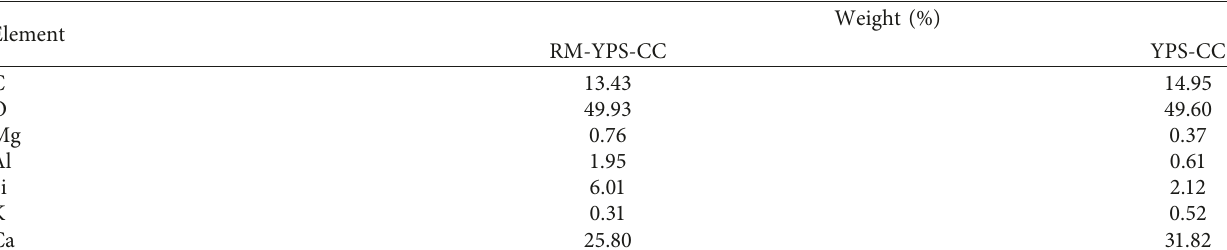
Figure 7: EDS locations for paste in (a) RM-YPS-CC and (b) YPS-CC. Table 6: EDS chemical compositions of hardened concrete pastes